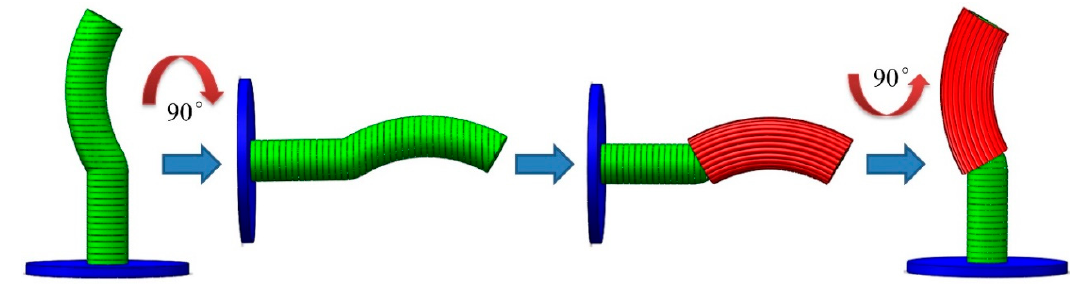
Figure 4. The printing process for axially reinforced pipes.